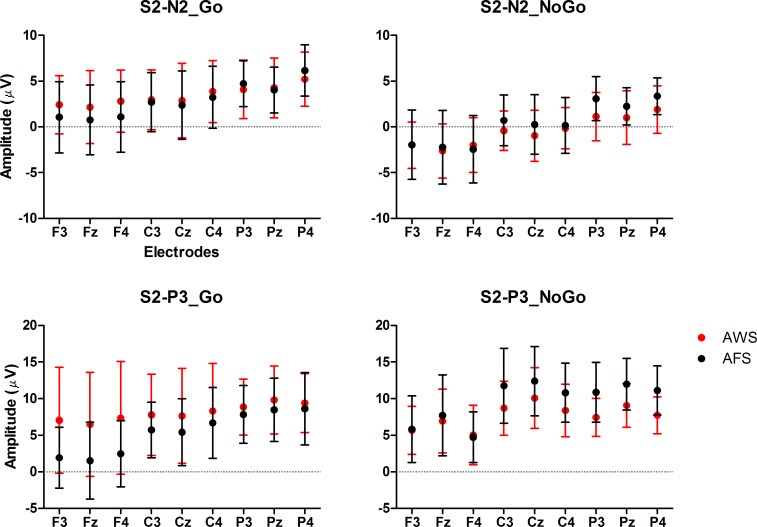
Peak amplitudes for AWS and AFS.The mean peak amplitudes and the standard deviations of S2-N2 and S2-P3 elicited by the Go and the NoGo signals are shown for AWS and AFS.